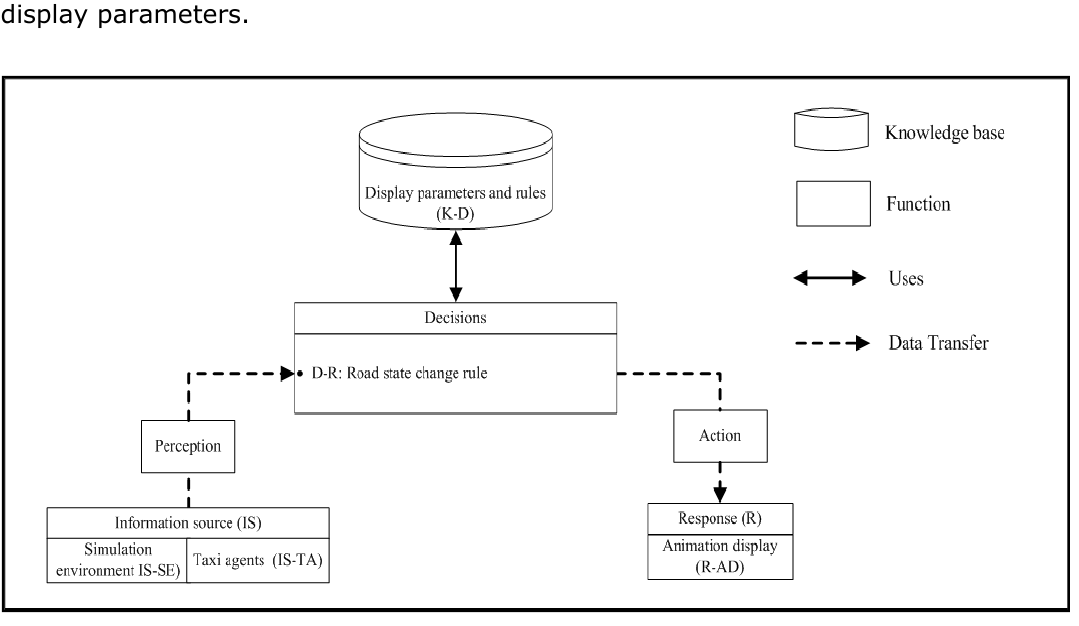
Figure 7. “The framework of Road agent”.